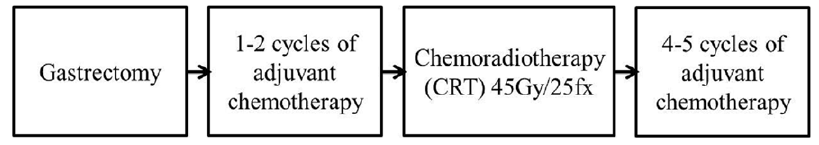
Figure 1. The flow chart of the recommended treatment strategy.